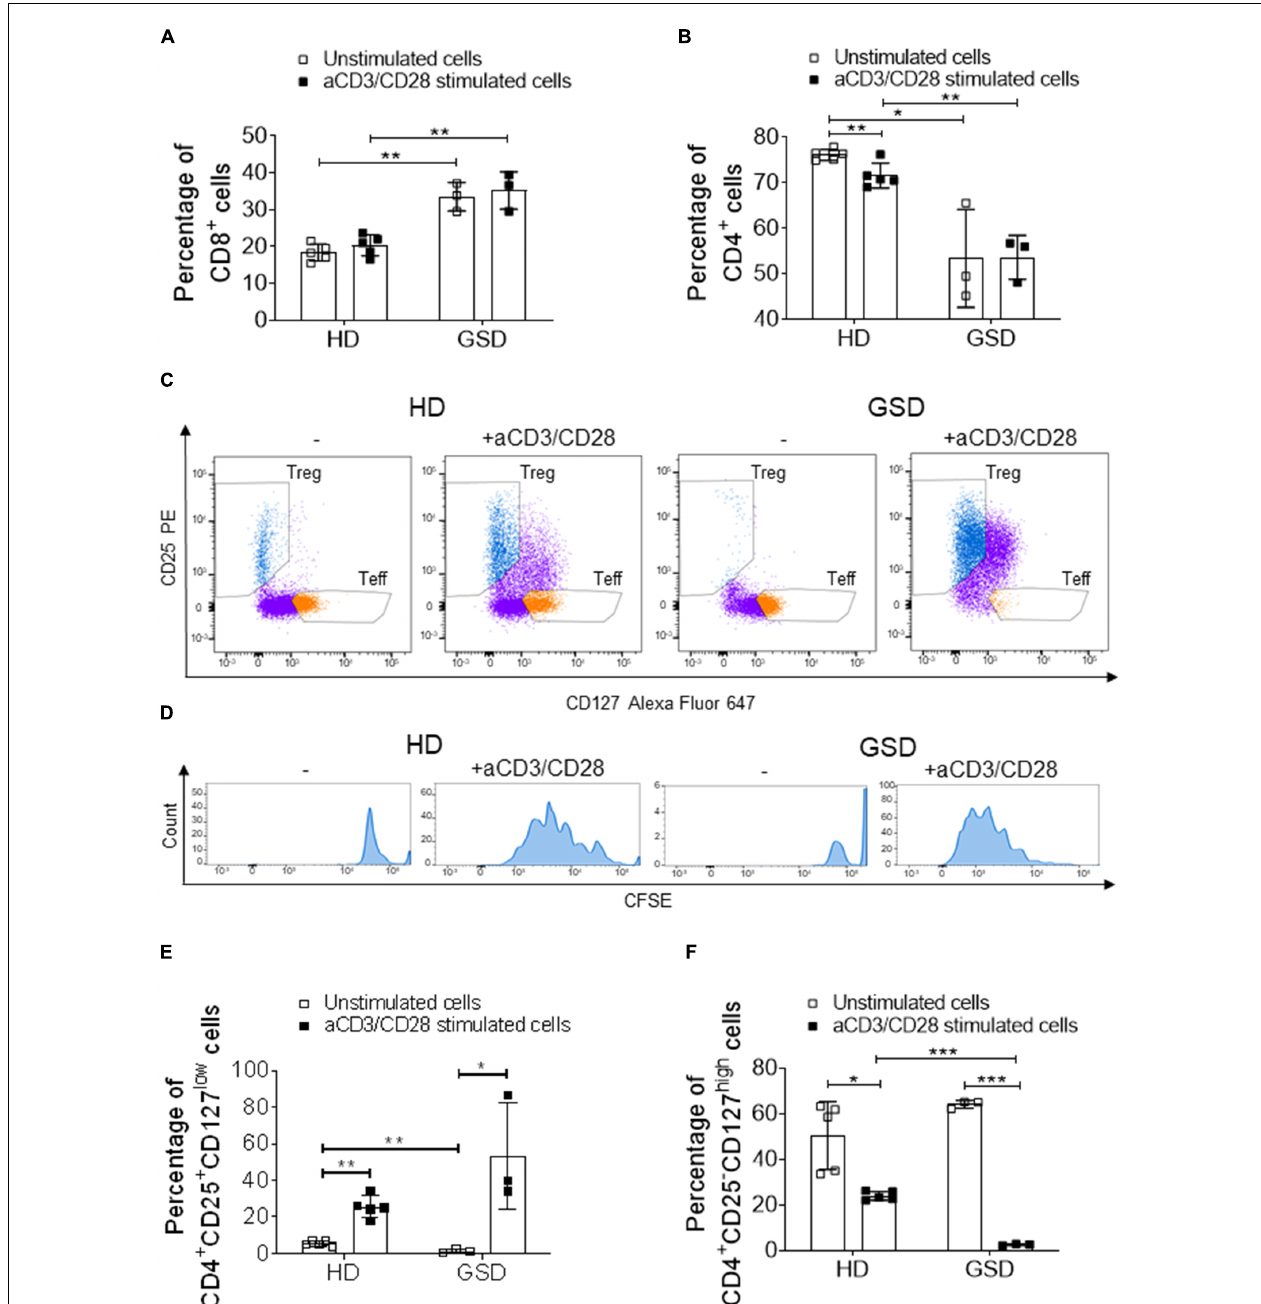
FIGURE 3 | Cytometric analysis performed on PBMC, isolated from three patients and five HD, stimulated or not with aCD3/CD28 beads for 5 days. (A) Percentage of CD8 + cells and (B) CD4 + cells in CD3 + gate. (C) Representative FACS plots of HD and GSD CD4 + cells with or without anti-CD3/CD28 (CD4 + cells are marked in purple, while T reg and Teff are reported in blue and orange, respectively). (D) Representative plots of CFSE + -labeled proliferative Treg (marked in blue) of HD and GSD patient stimulated or not with aCD3/CD28 beads. (E) Percentage of CD25 + CD127 low Treg in CD4 + gate. (F) Percentage of CD25 - CD127 high Teff in CD4 + gate. Results are expressed as mean ± SD. * p < 0.05; ** p < 0.01; *** p <